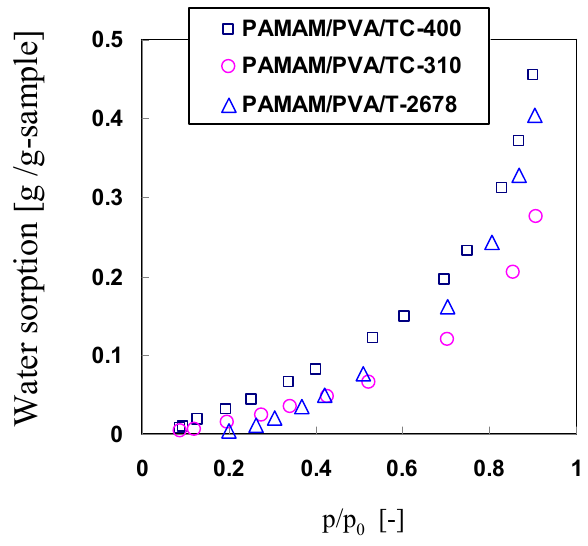
Figure 6. Effect of cross-linker on water sorption properties of the PAMAM/cross-linked PVA membranes at 40 °C.